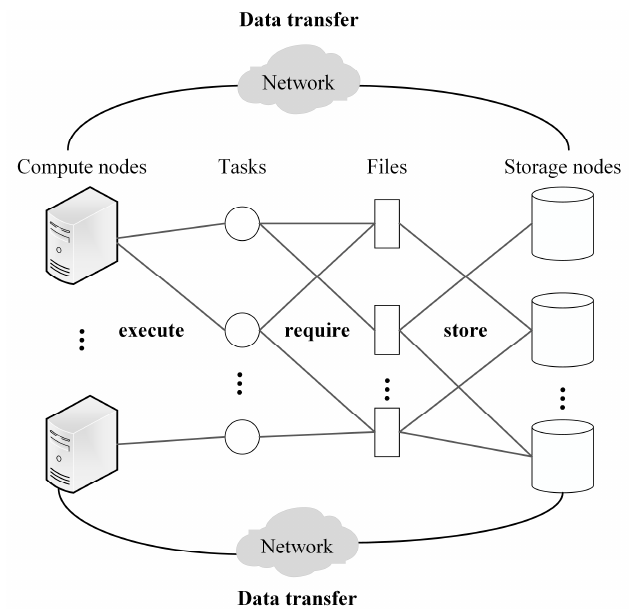
Figure 1. A typical data-intensive computing